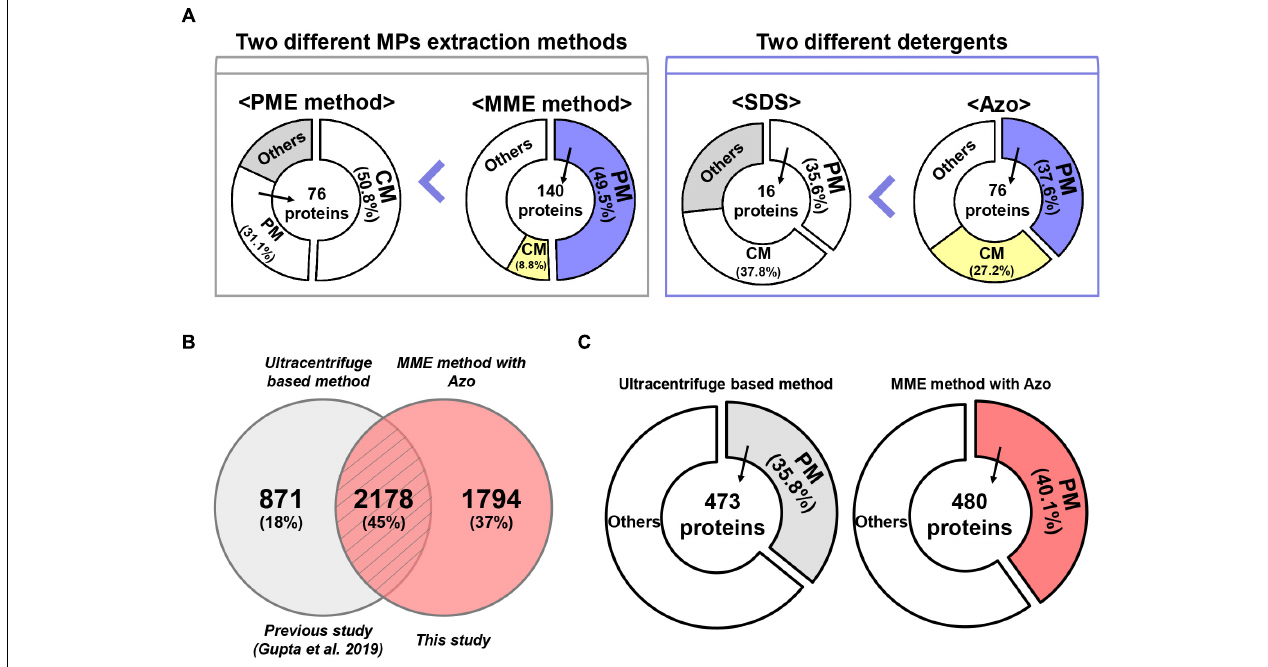
FIGURE 6 | A comparative analysis of MME vs. PME methods and SDS vs. Azo utilizing variable methods for microsomal proteomics. (A) The MME method revealed the successful enrichment of MPs, a particularly higher fraction of PM proteins in bottom-up proteomic analysis. Moreover, MPs, especially PM proteins, were solubilized more effectively in Azo and demonstrated differential proteomic identifications when compared with the SDS-based method. (B) Venn diagram and (C) subcellular localization showing a further comparison of the number of identified proteins in the current study and previous